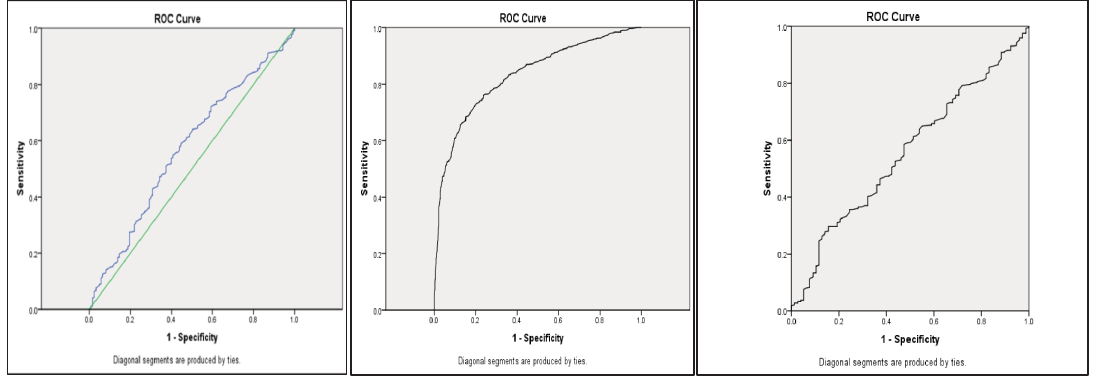
Fig 2. ROCs for CT values. ROCs for CT values against a) mortality (AUROC 0.569) and b) CTA (0.83) and c) recurrence (0.557).